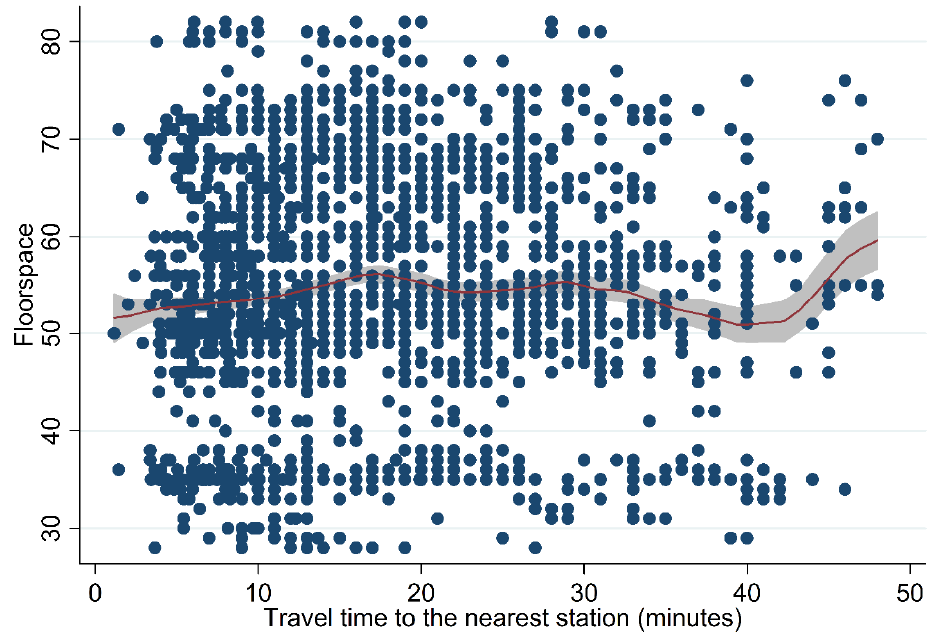
Figure 8. Floorspace plotted against travel time to the station.